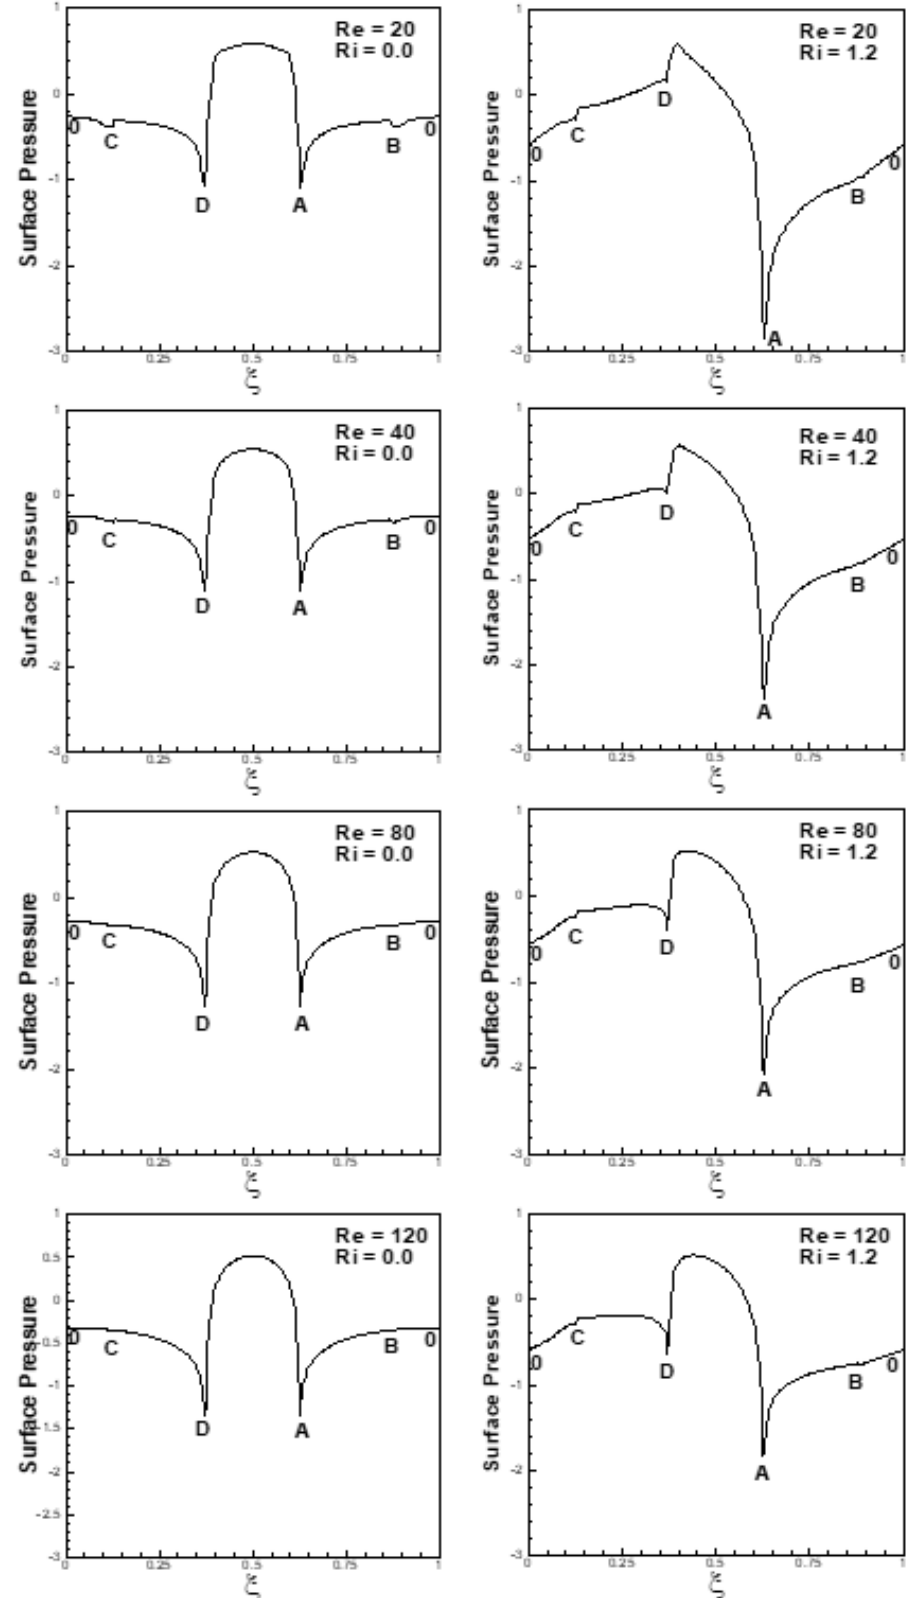
Figure 29. Variation of steady/mean pressure along the surface of cylinder at α = 90 °, Ri = 0 and 1.2 and 20 ≤ Re ≤ 120.